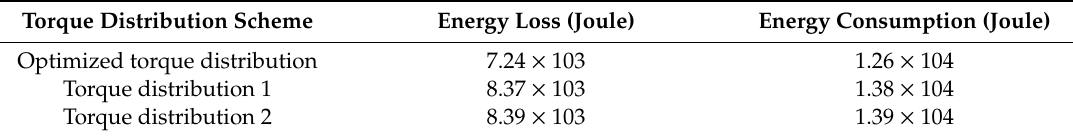
Table 2. Simulation results of total energy consumption for the curvilinear